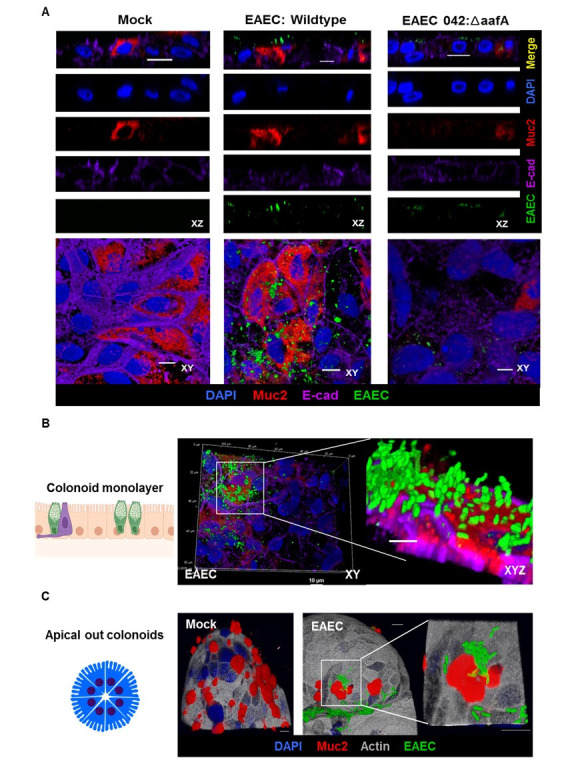
Association of EAEC to intestinal mucus (MUC2) to TC202, colon line as revealed by immunofluorescence micrographs.(A) Representative confocal micrographs of HIEMs stained for nuclei (DAPI, blue), MUC2 (Red), E-cadherin (Purple) and EAEC (GFP, green). HIEMs were either mock treated or infected with EAEC A2A:GFP or EAEC:ΔaafA at a MOI of 10 for three hours. (B) Volume projections of EAEC A2A:GFP infected HIEMs (C) EAEC infection on apical out colonoids. 3D reconstruction images show EAEC growing above goblet cells secreting MUC2. (Inset shows higher magnification). Scale bars indicate 10μm.